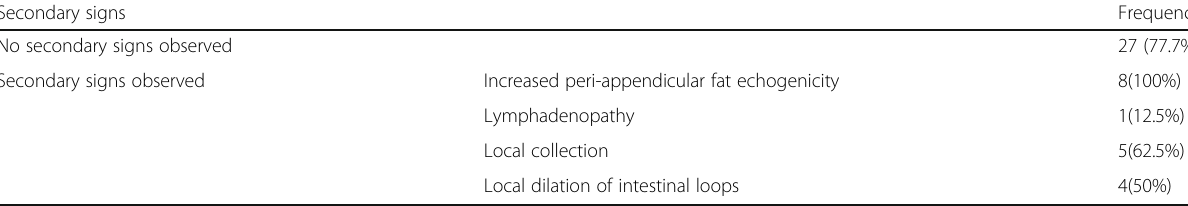
Table 3 Frequency of secondary signs in patients with un-observable appendicitis Secondary signs